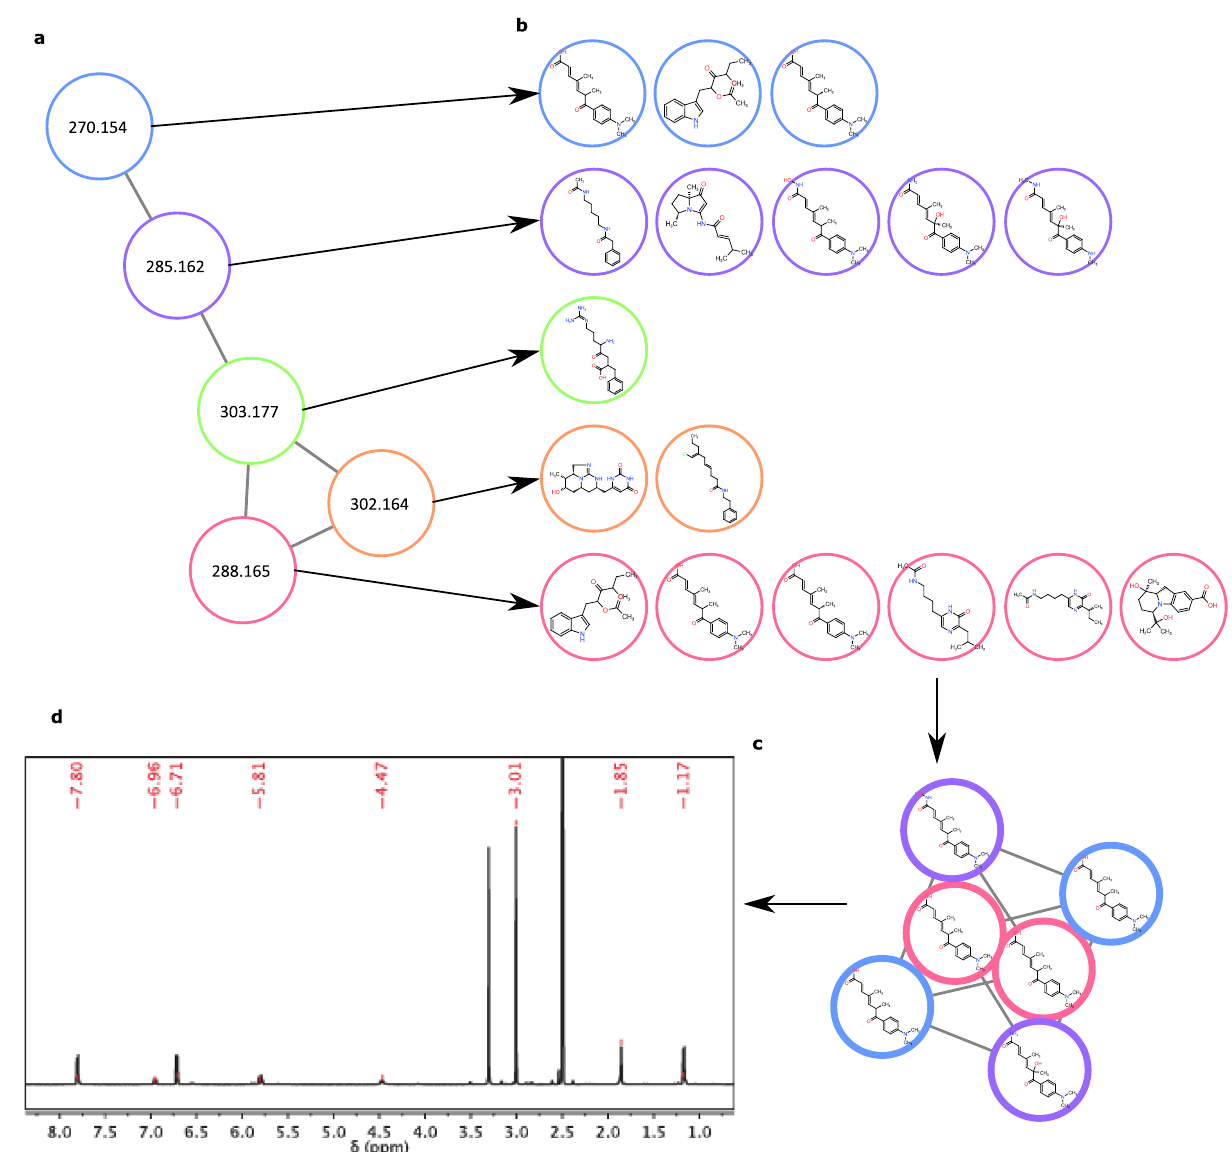
Fig. 3 | SNAP-MS work fl ow. The compound family annotation of a subnetwork showing a theinputsubnetwork, b candidatestructuresretrievedfromtheNatural ProductsAtlasforeachmassfrompanela.Nodeedgecolorindicatesoriginalmass